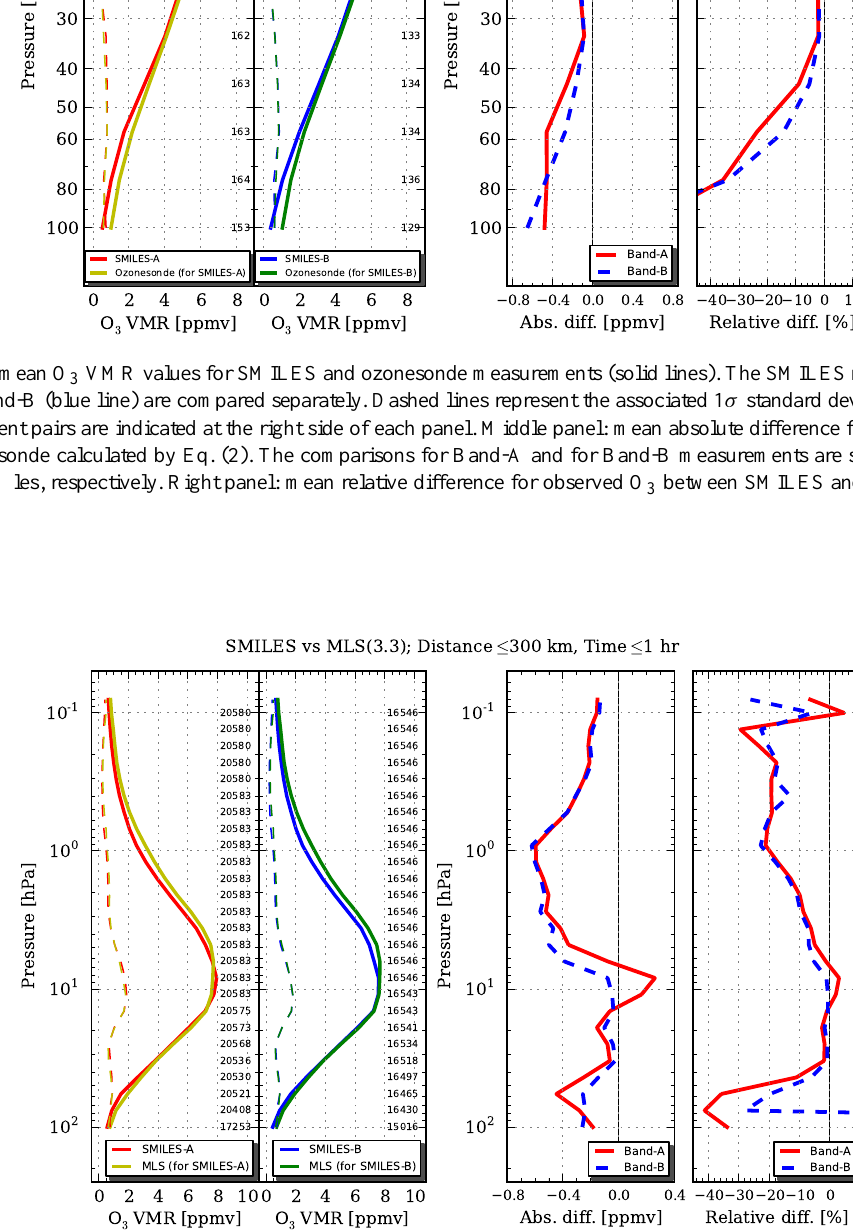
Fig. 13. Comparison between SMILES and MLS O 3 profiles. See Fig. 12 for the plot format.